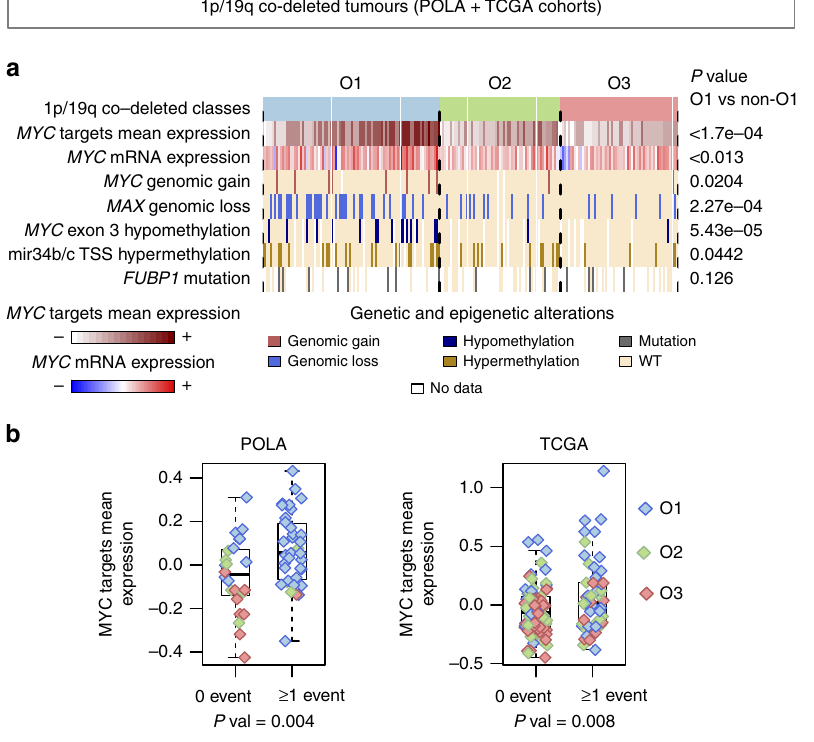
Figure 5 | Overview of MYC -related genomic and epigenomic alterations frequently observed in O1 tumours. ( a ) Summary of MYC -related genetic and epigenetic alterations in pooled data from both POLA (80 co-deleted gliomas) and TCGA (131 co-deleted gliomas) cohorts. The pooled sample sizes of O1, O2 and O3 classes are respectively 90, 61 and 60 tumours. The mean expression of MYC targets was computed for each sample to get a measure of MYC activation. ( b ) Relation between the presence of at least one MYC deregulation event ( MYC genomic gain, MAX genomic loss, MYC exon 3 hypomethylation, mir34b/c TSS hypermethylation) and MYC activity measured through the mean expression of MYC targets. For each dataset, y axis show the mean expression values after centring on the samples. For each box and whiskers plot, bottom and top of the boxes are the first and third quartile of the data and whiskers represent the lowest (respectively highest) data point still within 1.5 interquartile range of the lower (respectively upper) quartile. Bold lines represent median